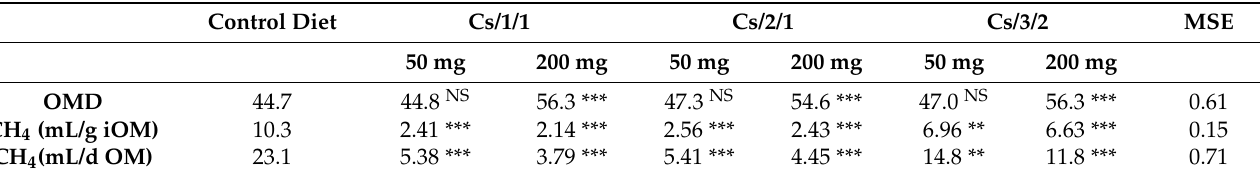
methanogenesis, which is consumed by the formation of propionate from pyruvate [53]. After 24 h of incubation, acetic acid was reduced in all samples tested, with the sole exception of Cs/3/2-50 mg, which favors a 3.7% increase over the control diet. Instead, by Cs/3/2-50 mg. The higher molar proportion of propionate in the in vitro fermentation system may be associated with a lower count of protozoa produced by tannins [47,50].